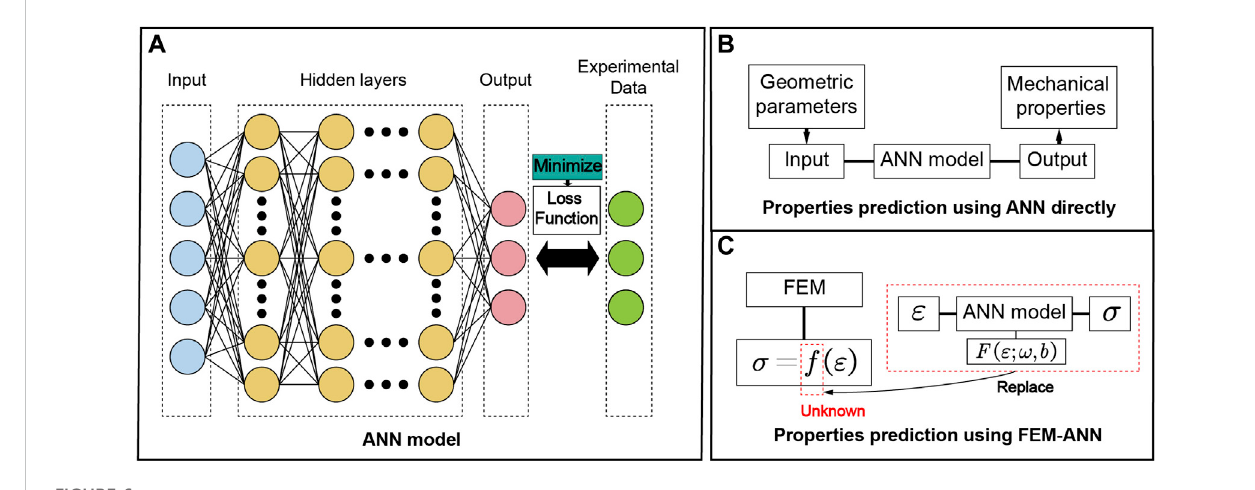
FIGURE 6 Prediction of properties of composites by ANN. (A) ANN model, (B) Predicting the properties of composite materials using ANN directly, (C) Predicting the properties of composite materials by combining ANN and fi nite element